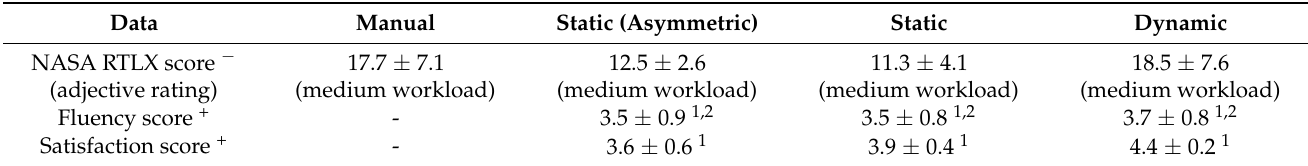
Table 5. Assessment results for workload, fluency, and satisfaction for the different task alloca- tion